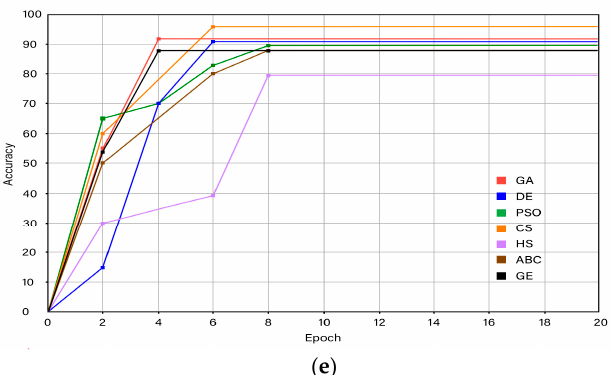
Figure 6. The training curve of the proposed algorithm on seven datasets, including ( a ) Iris, ( b ) Cancer, ( c ) Diabetes, ( d ) Liver, and ( e ) Wine. The red line indicates the learning curve of GA, the blue line that of DE, the green line that of PSO, the orange line that of SC, the purple line that of Harmony Search, the black line that of GE, and the brown line that of ABC.